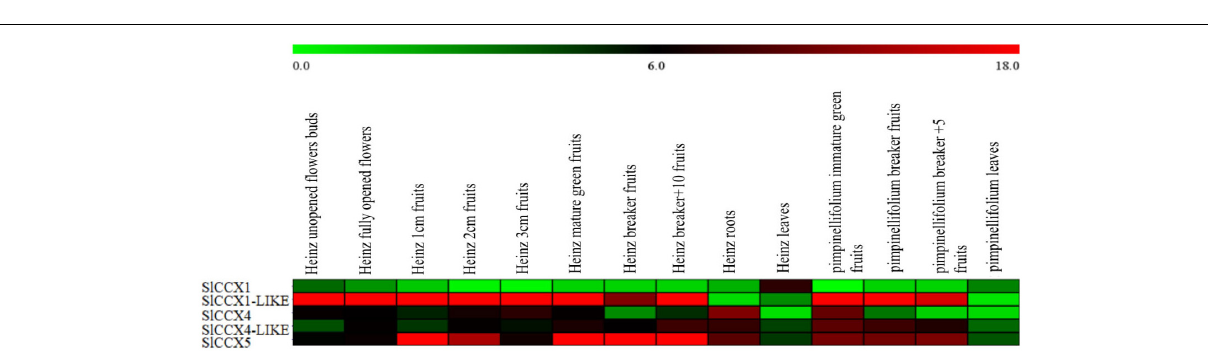
FIGURE 5 | Heatmap showing differentially expressed SlCCX1-LIKE. Note: Red represents high expression, green represents low expression, and the expression in the figure represents the actual expression of log2 value. From left to right is Heinz unopened flowers buds; Heinz 1 cm fruits; Heinz 2 cm fruits; Heinz 3 cm fruits; Heinz mature green fruit; Heniz breaker fruits; Heniz breaker + 10 fruits; Heinz roots; Heniz leaves; S. pimpinellifolium immature green fruits; S. pimpinellifolium breaker + 5 fruits; S. pimpinellifolium